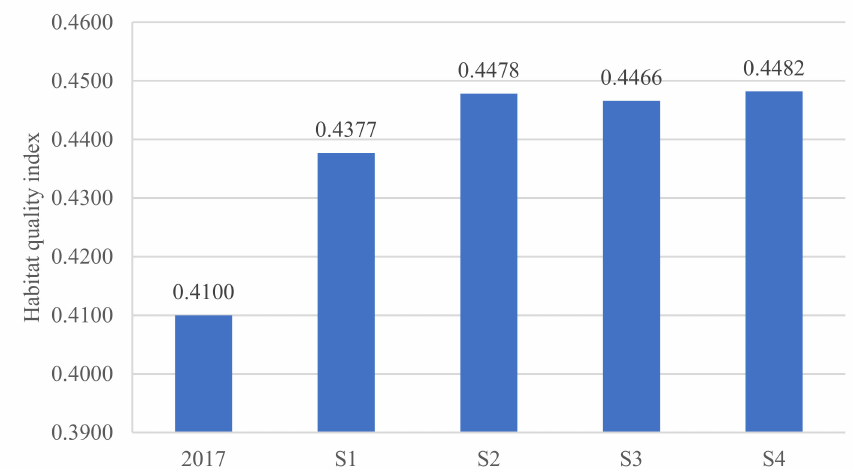
Figure 7. Comparison of habitat quality index in 2017 and 2030 under different scenarios.